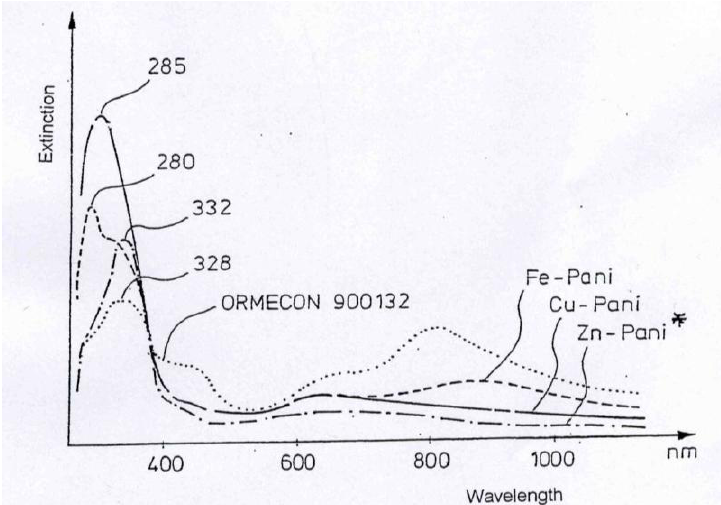
Figure 1. UV-Vis spectra for polyaniline and its complexes with Cu, Fe and Zn.